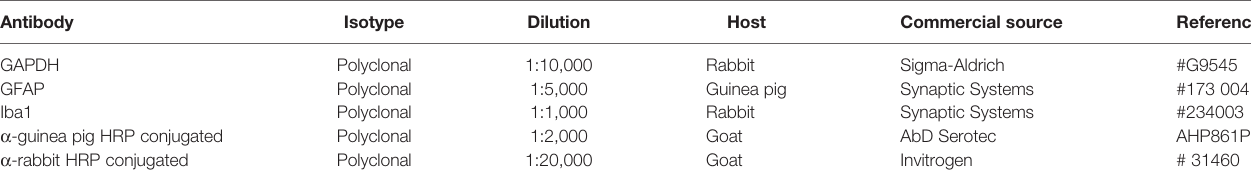
TABLE 1 | Antibodies used for Western